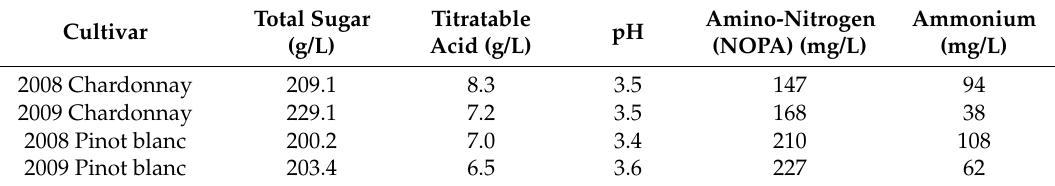
Table 1. Analytical data of grape musts prior to